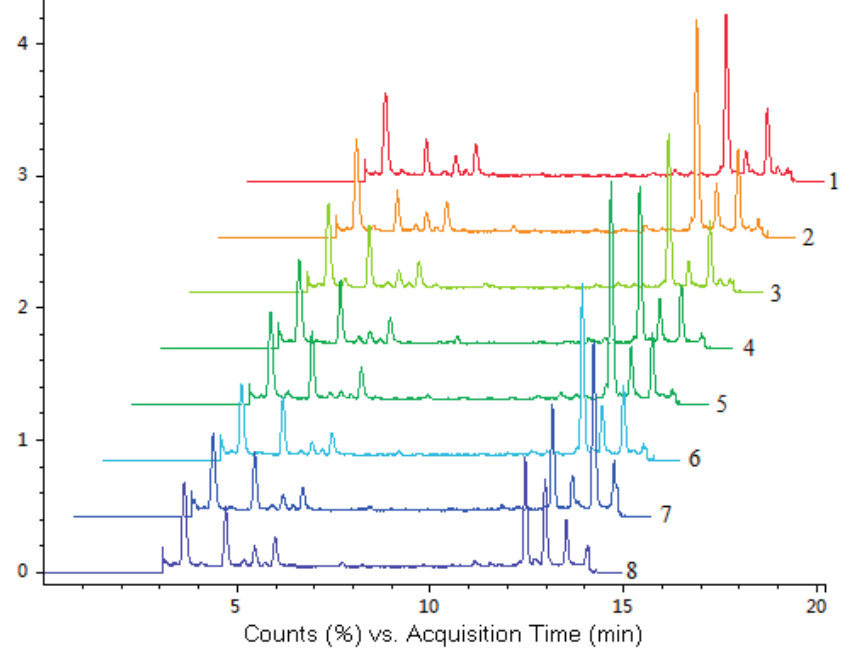
Figure 2. LC-Q-TOF-MS total ion chromatograms (TIC) of eight samples of H. sabdariffa . Different samples (No. 1–8) are listed in Table 4.